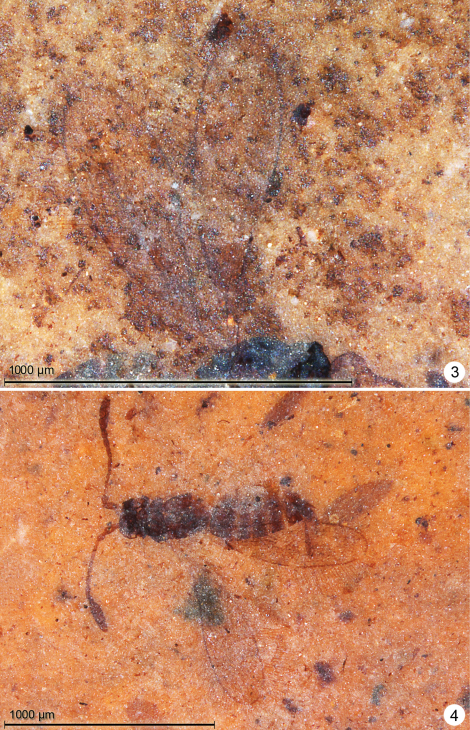
Eoeustochus kishenehn
3 wings, holotype 4 paratype, habitus dorsal.